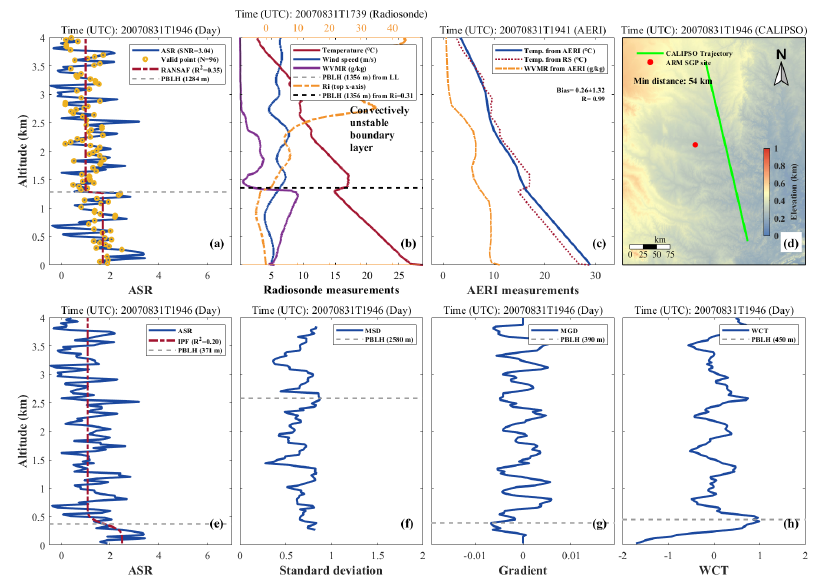
Figure 11. ASR was measured using CALIOP at 19:46:46 UTC (day) on 31 August 2007; PBLHs were determined by using ( a ) RANSAF, ( b ) radiosonde (RS), ( e ) IPF, ( f ) MSD, ( g ) MGD, and ( h ) WCT methods; ( c ) vertical profile of temperature and water vapor mixing ratio (WVMR) retrieved from AERI with the red dotted line refer to the temperature measured by RS in ( b ), Bias (R) is the mean difference (correlation coefficient) between temperature profiles from AERI and RS; ( d ) ARM SGP site of radiosonde observations and CALIPSO trajectory. The minimum distance between the CALIOP and radiosonde (AERI) measurements are shown at the top of subfigure ( d ).